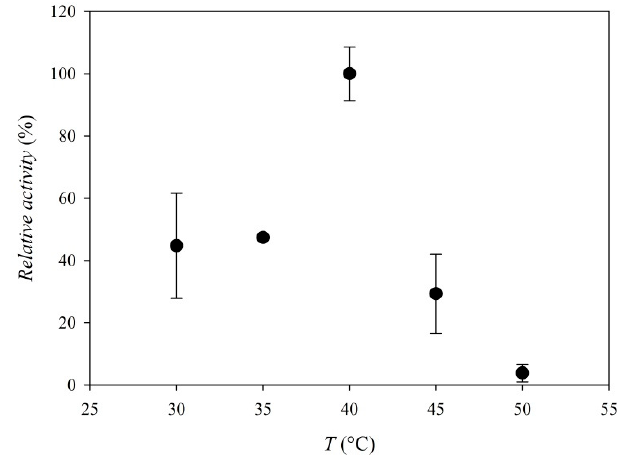
Figure 2. Dependence of lipase activity on temperature .